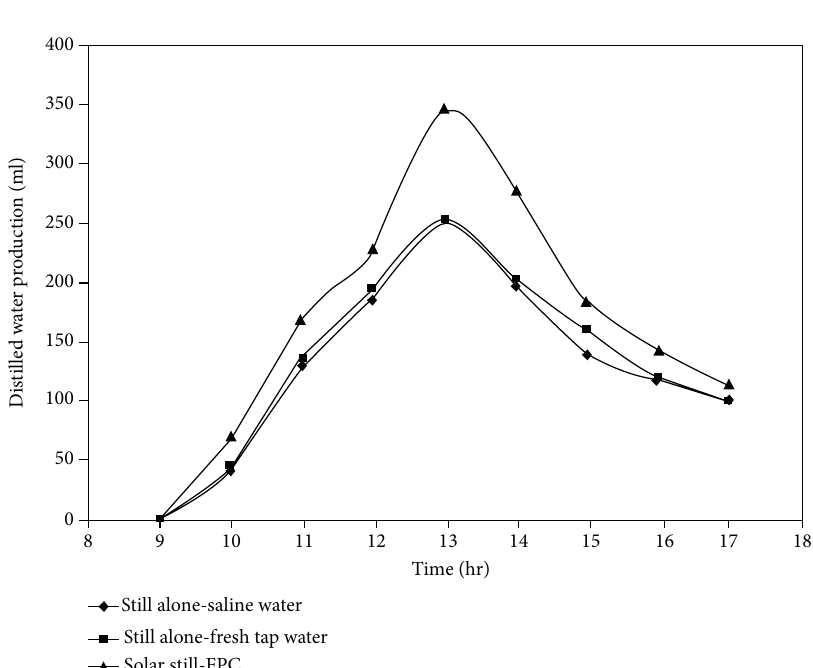
Figure 21: Cost of di ff erent types of solar stills.